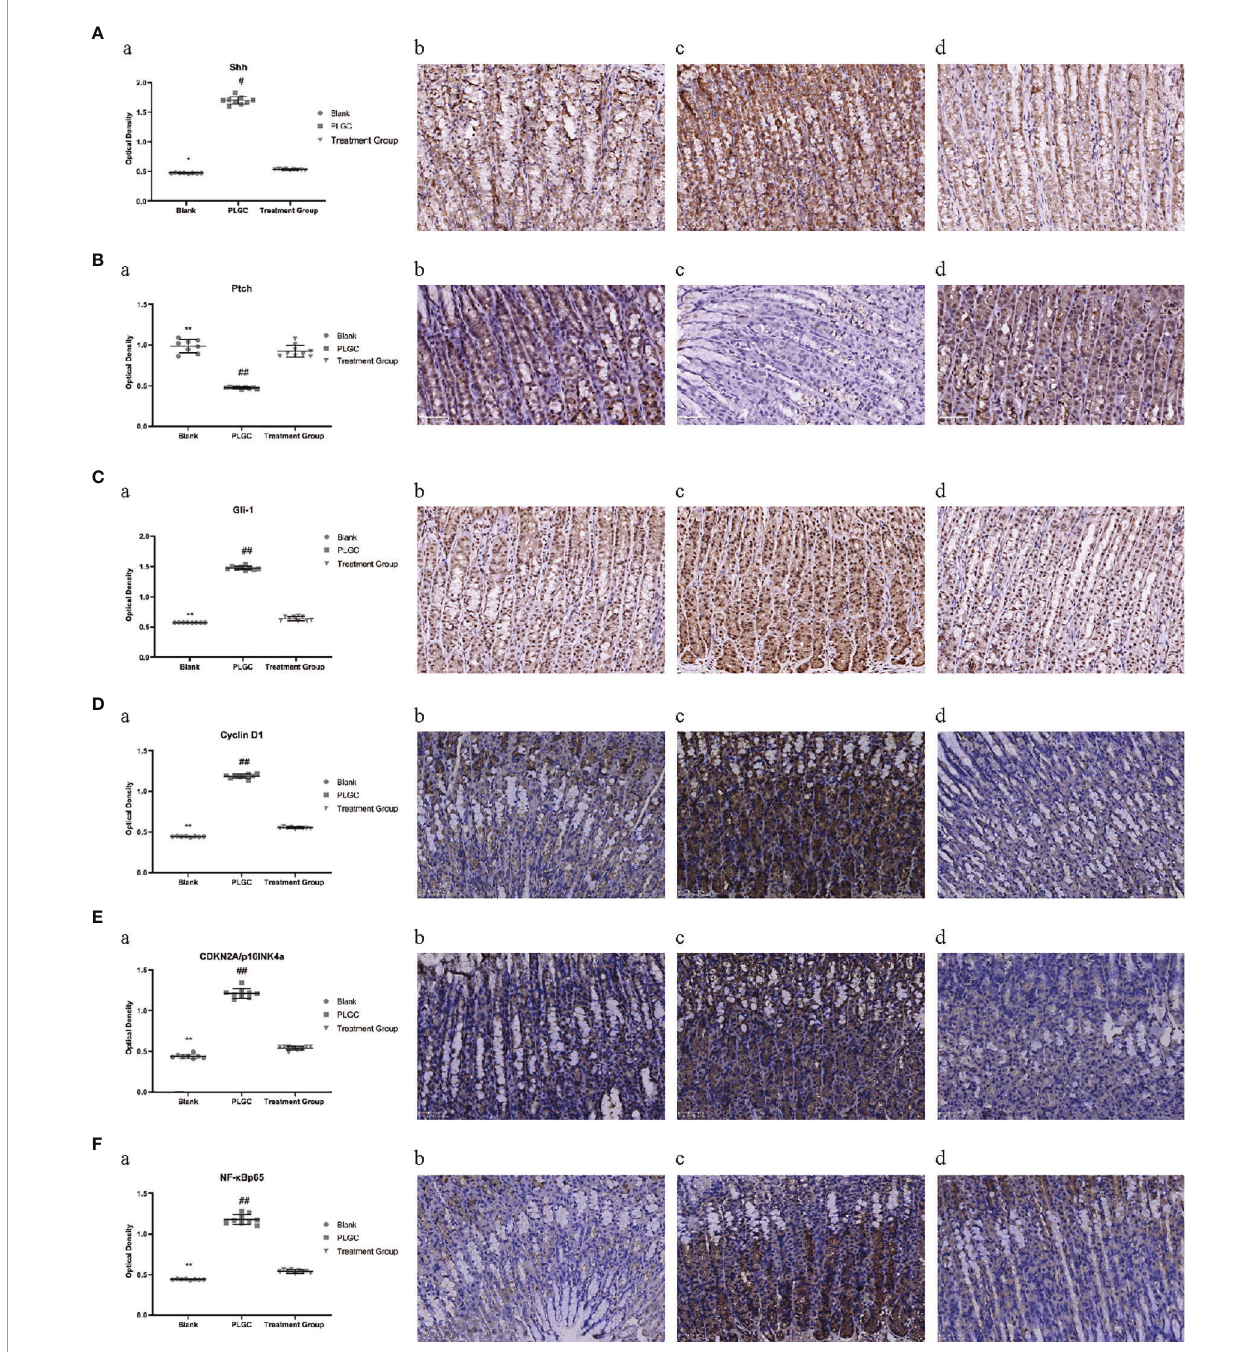
FIGURE 6 | Comparison of expression levels of Shh, Ptch, Gli-1, Cyclin D1, CDKN2A/p16INK4a, and NF- k Bp65 protein in the gastric tissue of rats in different groups. (A) The expression level of Shh protein in the gastric tissue of rats in each group was detected by immunohistochemistry. (B) The expression level of Ptch protein in the gastric tissue of rats in each group was detected by immunohistochemistry. (C) The expression level of Gli-1 protein in the gastric tissue of rats in each group was detected by immunohistochemistry. (D) The expression level of cyclin D1 protein in the gastric tissue of rats in each group was detected by immunohistochemistry. (E) The expression level of CDKN2A/p16INK4a protein in the gastric tissue of rats in each group was detected by immunohistochemistry. (F) The expression level of NF- k Bp65 protein in the gastric tissue of rats in each group was detected by immunohistochemistry. * P < 0.05 vs. blank; ** P < 0.01 vs. blank; # P < 0.05 vs. PLGC; ## P < 0.01 vs. PLGC. Scale bar: